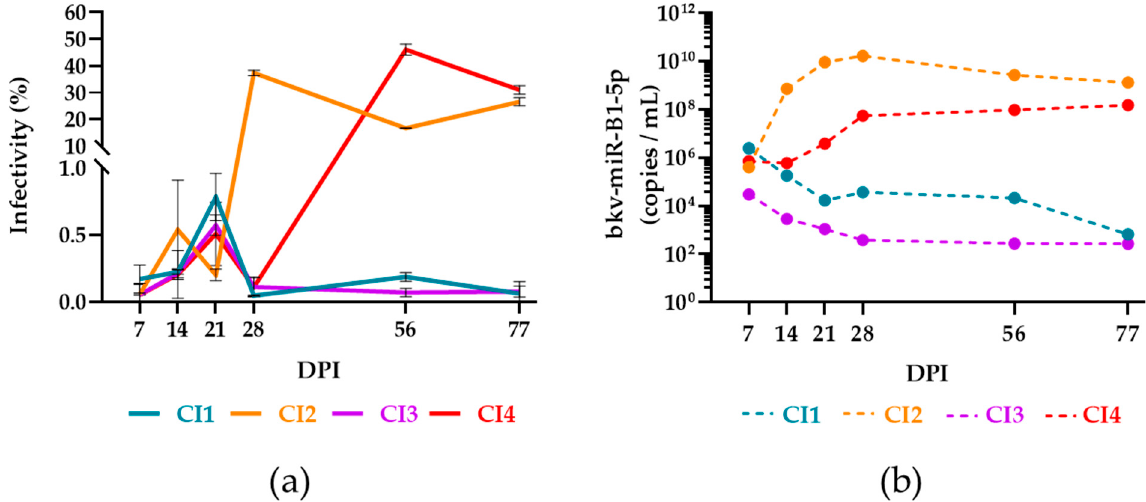
Figure 5. ( a ) Infectivity of conditioned media recovered from HRPTEC infected with 4 BKPyV clinical isolates (CI) 7 to 77 days post-infection (DPI). Infectivity rate corresponds to the percentage of cells that express BKPyV TAg among observed cells. The lines connect the mean infectivity rates between replicates. Errors bars represent standard deviation from the mean of duplicates. ( b ) bkv-miR-B1-5p level in conditioned media from HRPTEC infected with 4 BKPyV clinical isolates (CI) 7 to 77 days post-infection (DPI).